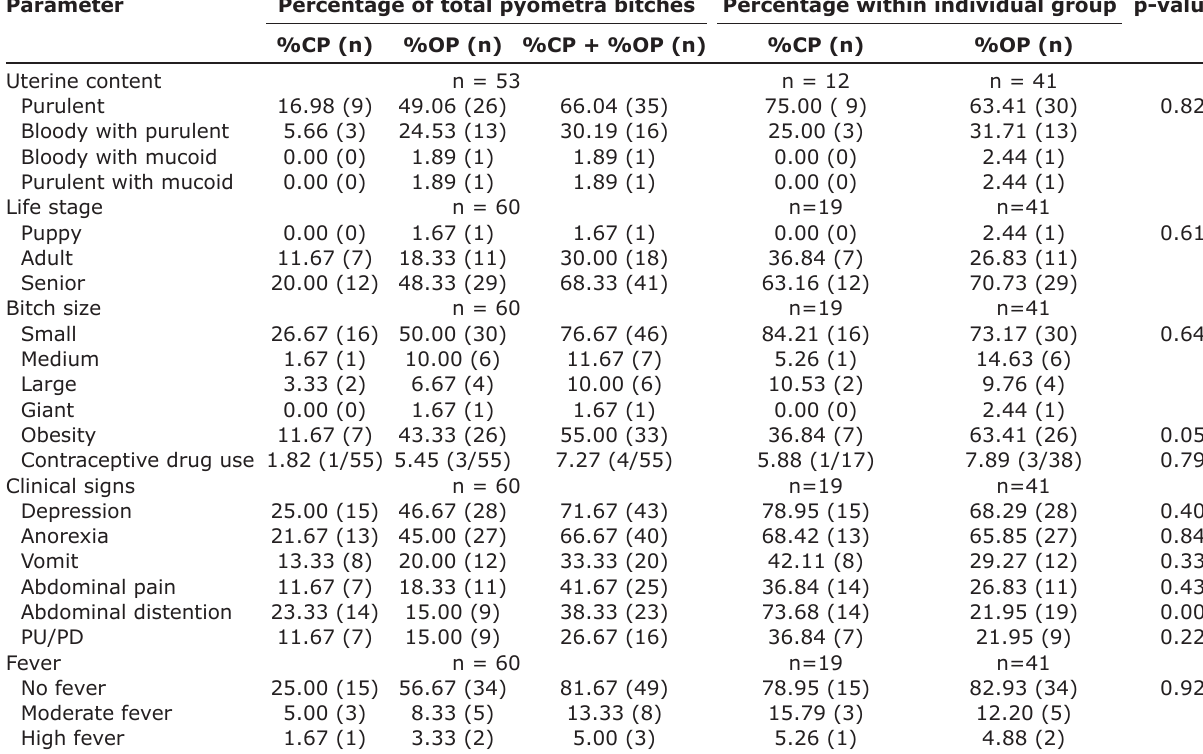
Table-4: Percentages of parameters in total pyometra bitches (n = 60) and within CP (CP, n = 19) and OP (OP, n = 41) groups. Parameter